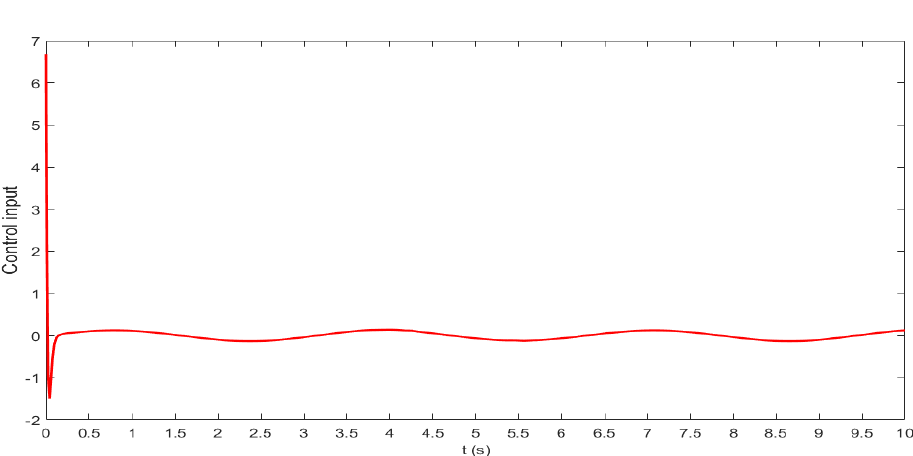
Figure 16. Control input curve.